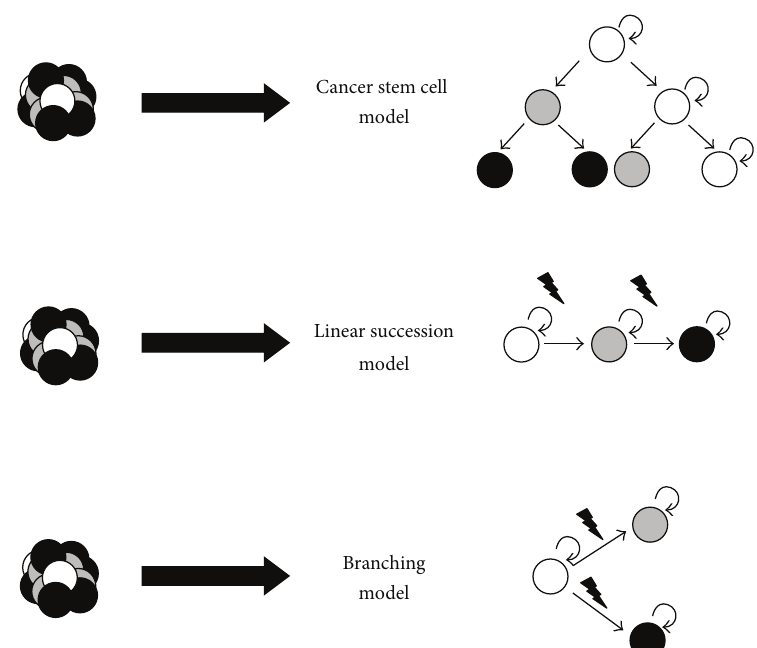
Figure 1: Different models explaining tumor cell heterogeneity. The cancer stem cell model describes stem cell-like LICs at the apex of a tumor cell differentiation hierarchy, exclusively having self-renewal potential and giving rise to all other cells of the leukemic bulk cells, which do not have LIC activity. In contrast, the clonal evolution models show no differentiation hierarchy and the main assumption is that individual subclones acquire successive mutations resulting in an ongoing subclonal evolution leading to intratumoral heterogeneity either in a linear or branching fashion. Importantly, these models are not mutually exclusive and a combination of both models contributes to tumor cell